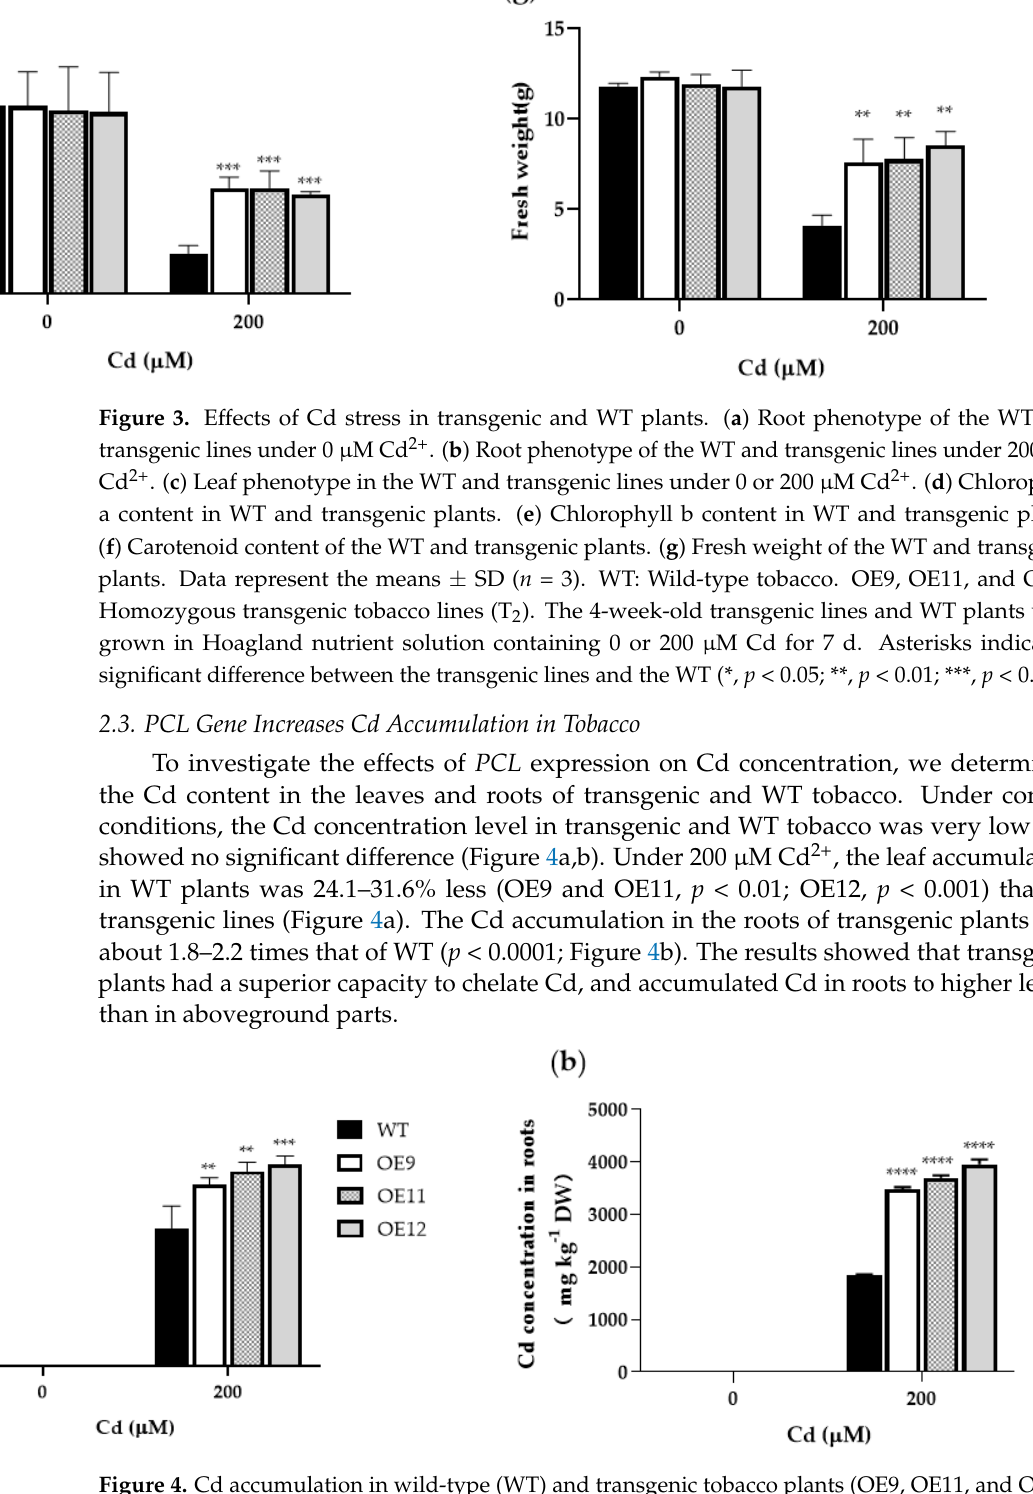
Figure 4. Cd accumulation in wild-type (WT) and transgenic tobacco plants (OE9, OE11, and OE12). ( a ) Cadmium concentrations in leaves. ( b ) Cadmium concentrations in the roots. The 4-week-old transgenic lines and WT plants were grown in Hoagland nutrient solution containing 0 or 200 µ M Cd for 7 d. Data represent the means ± SD (n = 3). Asterisks indicate a significant difference between the transgenic lines and the WT (**, p < 0.01; ***, p < 0.001; ****, p < 0.0001).